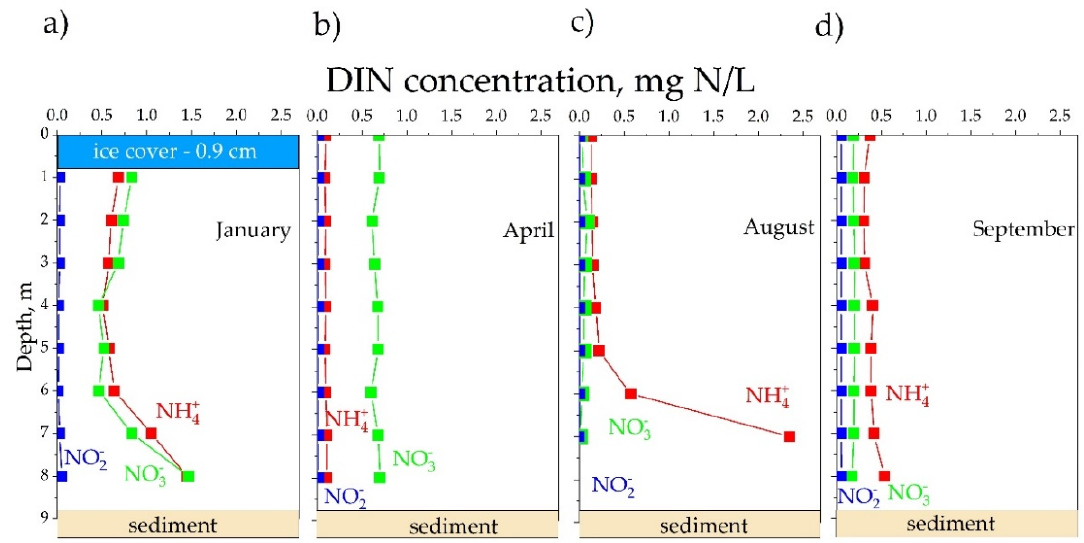
Figure 7. DIN concentration profiles at Bulan 2 station in ( a ) winter, ( b ) spring, ( c ) summer, and ( d ) autumn.